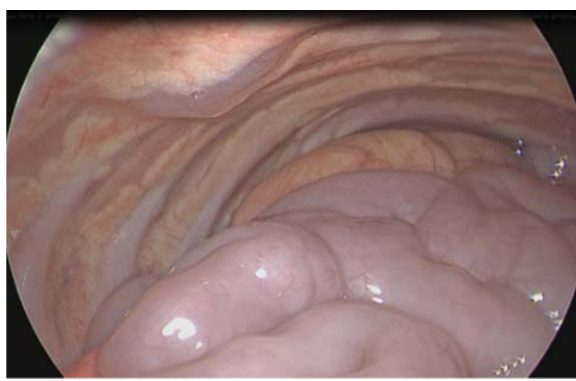
Fig. 3 Posterolateral diaphragmatic defect.